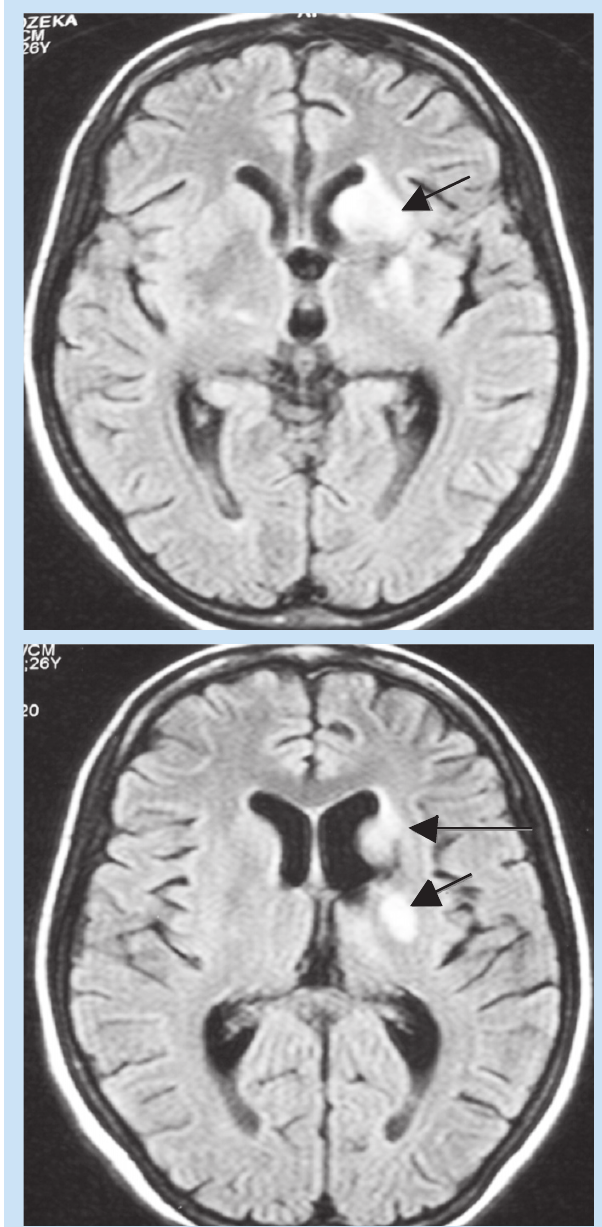
Fig. 2. CT scan of the brain with IV contrast. Indeterminate age infarcts of (a) left caudate head and (b) lentiform nucleus and (c) an old lentiform nucleus/ internal capsule infarct.